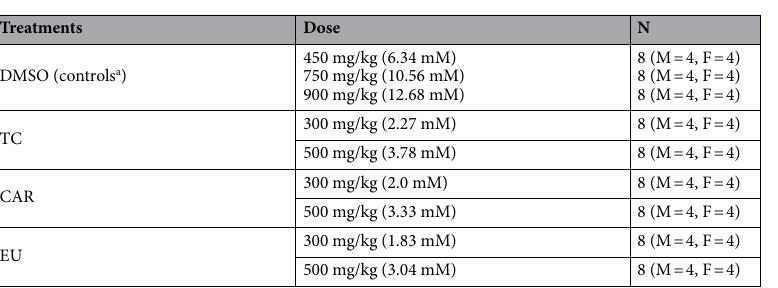
Table 1. Levels of PDAs used for treatments. DMSO was used as the vehicle control. a Three different control groups were needed in order to control for the different concentrations of DMSO used in different PDA treatments. The controls and treated mice corresponded as follows: 10.56 mM (or 750 mg/kg) DMSO to control for 500 mg/kg TC and 500 mg/kg EU; 6.34 mM (or 450 mg/kg) DMSO for 300 mg/kg TC, 300 mg/kg EU, and 300 mg/kg CAR; and 12.68 mM (or 900 mg/kg) DMSO for 500 mg/kg CAR, respectively. The molar concentrations were calculated based on PDA/DMSO injected over body volumes (based on the average body density of 1.1 g/mL 16